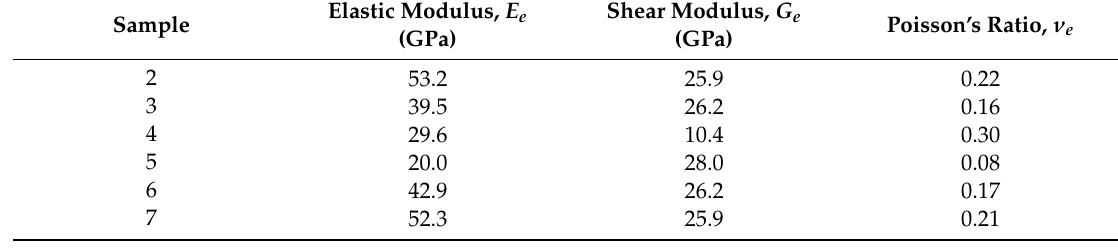
Table 4. Material properties of EM for finite element simulation.